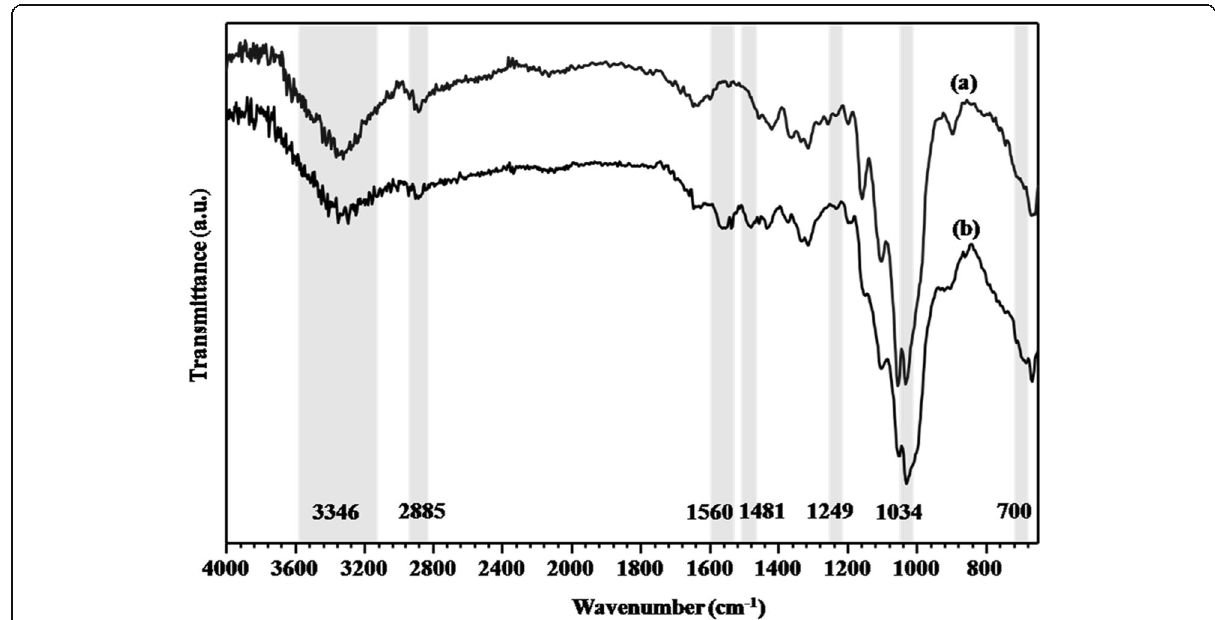
Fig. 1 FTIR Spectrum of ( a ) MCC and ( b ) MMCC